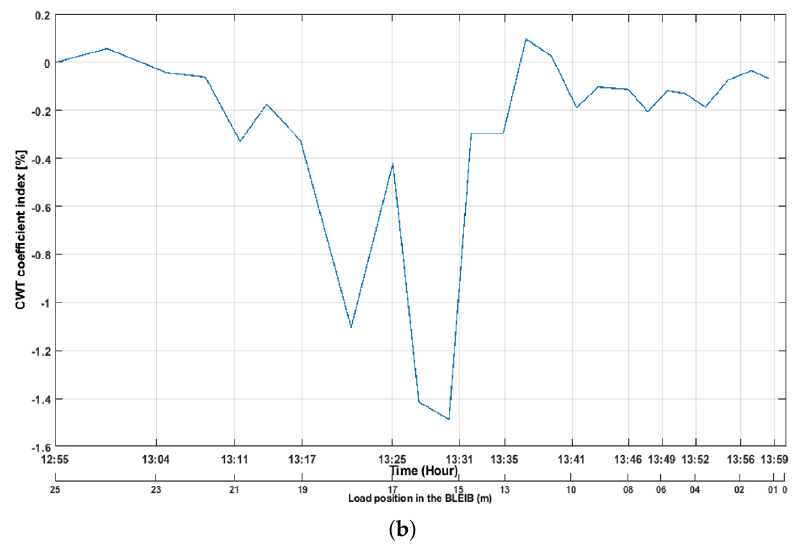
Figure 11. Coefficient indices from the sensor pair S10R12. ( a ) Values of cross-correlation coefficient ( Dcc ) index from the sensor pair S10R12; ( b ) Values of CWT coefficient index from the sensor pair